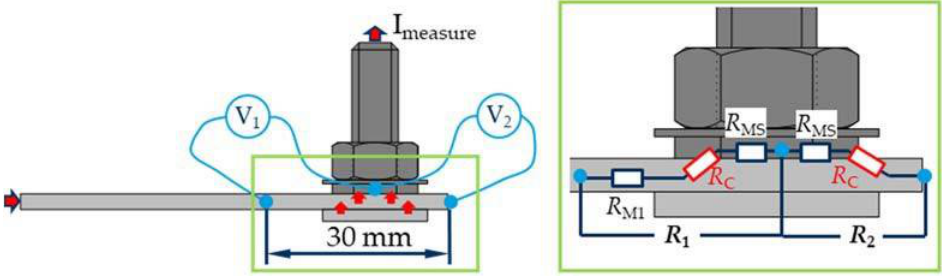
Figure 4. Measuring principle for determining the resistance of joints with the self-piercing stud [3].